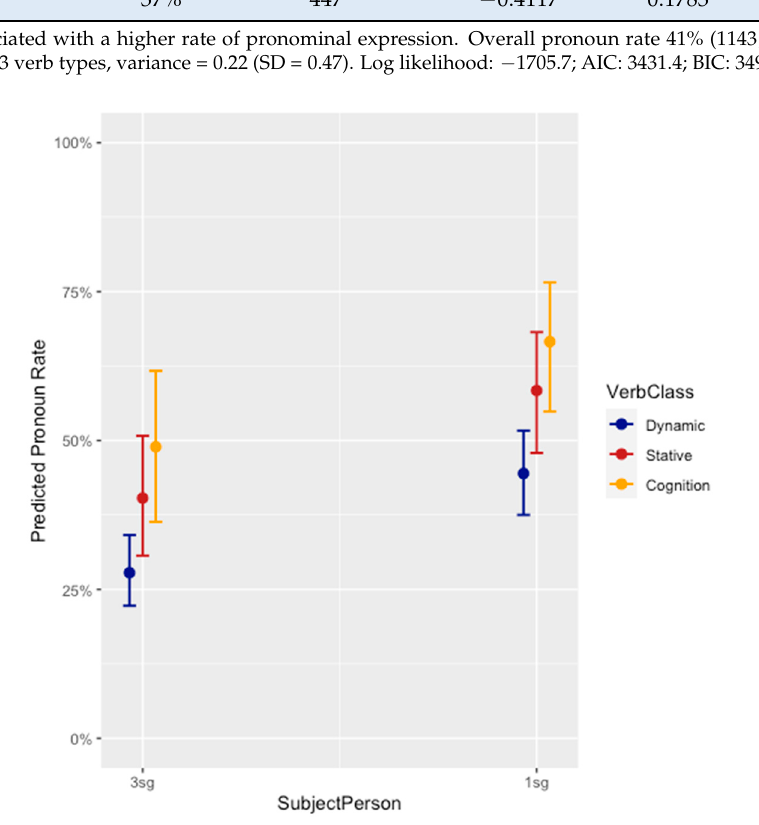
Figure 2. Data distribution for verb class by person. Cognition verbs are disproportionately 1sg. The very robust finding reported in the Spanish subject expression literature for cog- nition verbs, then, is actually accounted for by cognition verbs with 1sg subjects , as ob- served by Torres Cacoullos and Travis (2018, p. 102). The favoring of subject pronouns with specifically 1sg cognition verbs suggests a 1sg cognition verb construction, which we can represent as [( yo ) + COGNITION VERB 1 SG ]. Constructions, generally defined as pairings of form and meaning (e.g., Goldberg 2013), are operationalizable quantitatively as items tending to co-occur in particular contexts (Travis and Torres Cacoullos 2020, p. 140). Let us now explore the makeup of the 1sg cognition verb construction. 5. Straddling Lexical Types and Classes: Lexically Particular Constructions